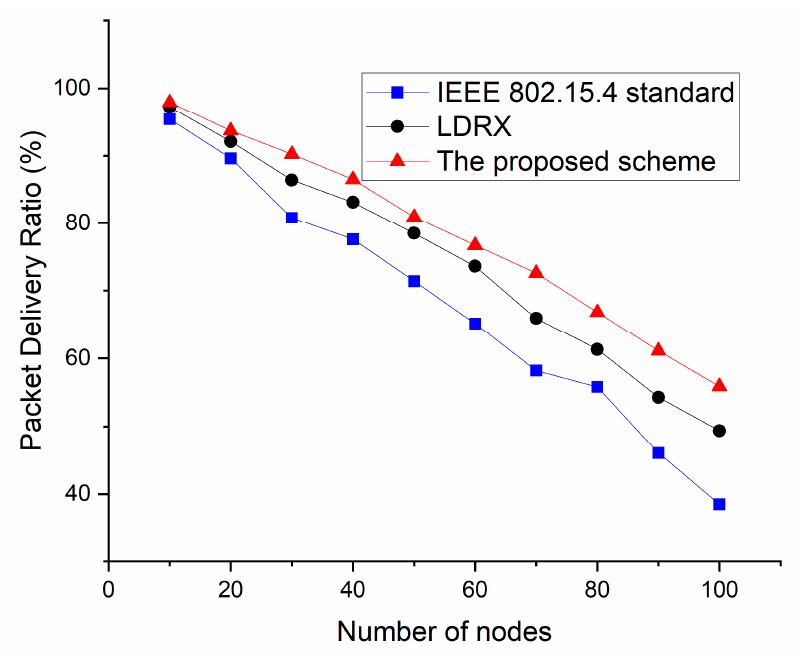
Figure 11. Packet delivery ratio as a function of the number of devices.